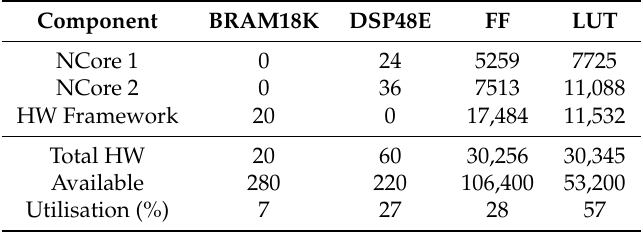
Figure 17. Stream Processing Unit (SPU) structure. Table 5. List of field-programmable gate array (FPGA) resources